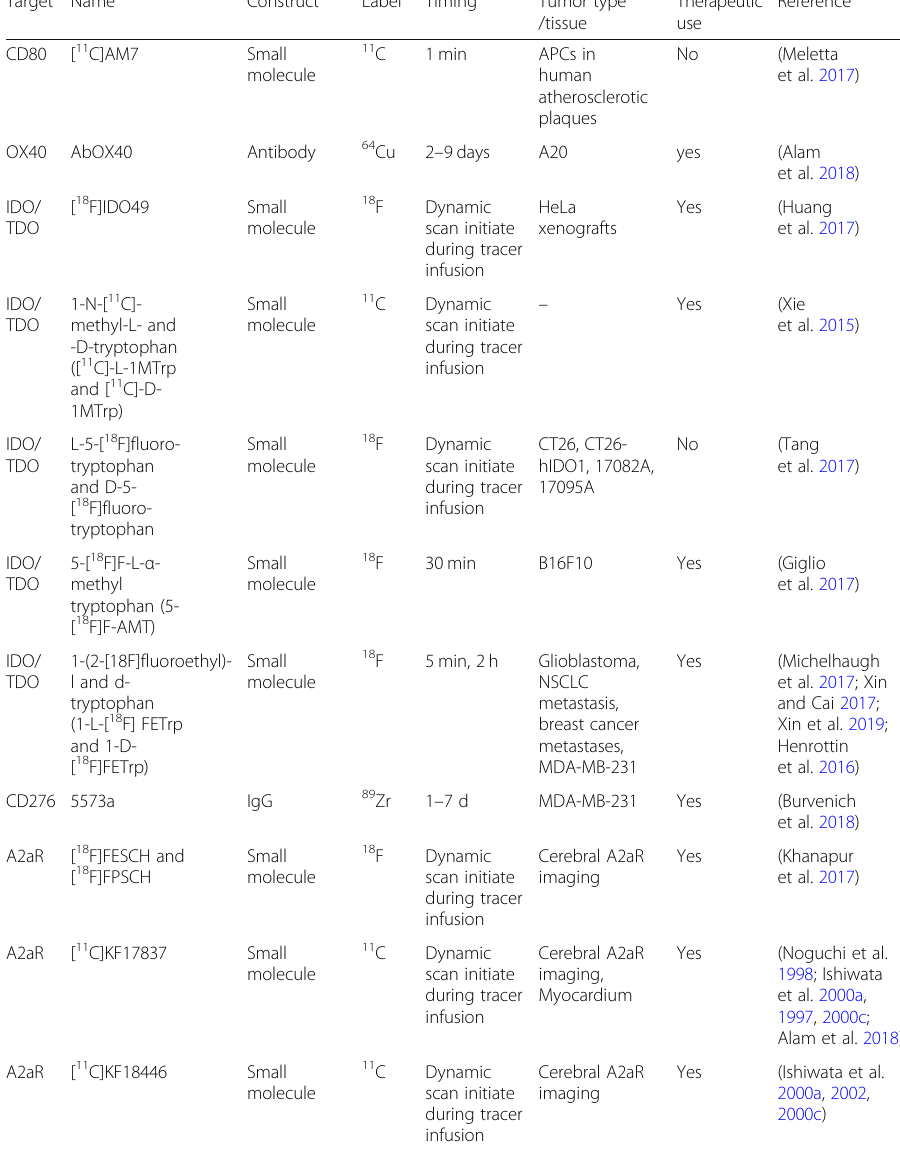
Table 1 Overview of nuclear imaging tracers for immune checkpoints. Only tracers that have been published and used in at least preclinical in vivo studies are described in the tables below